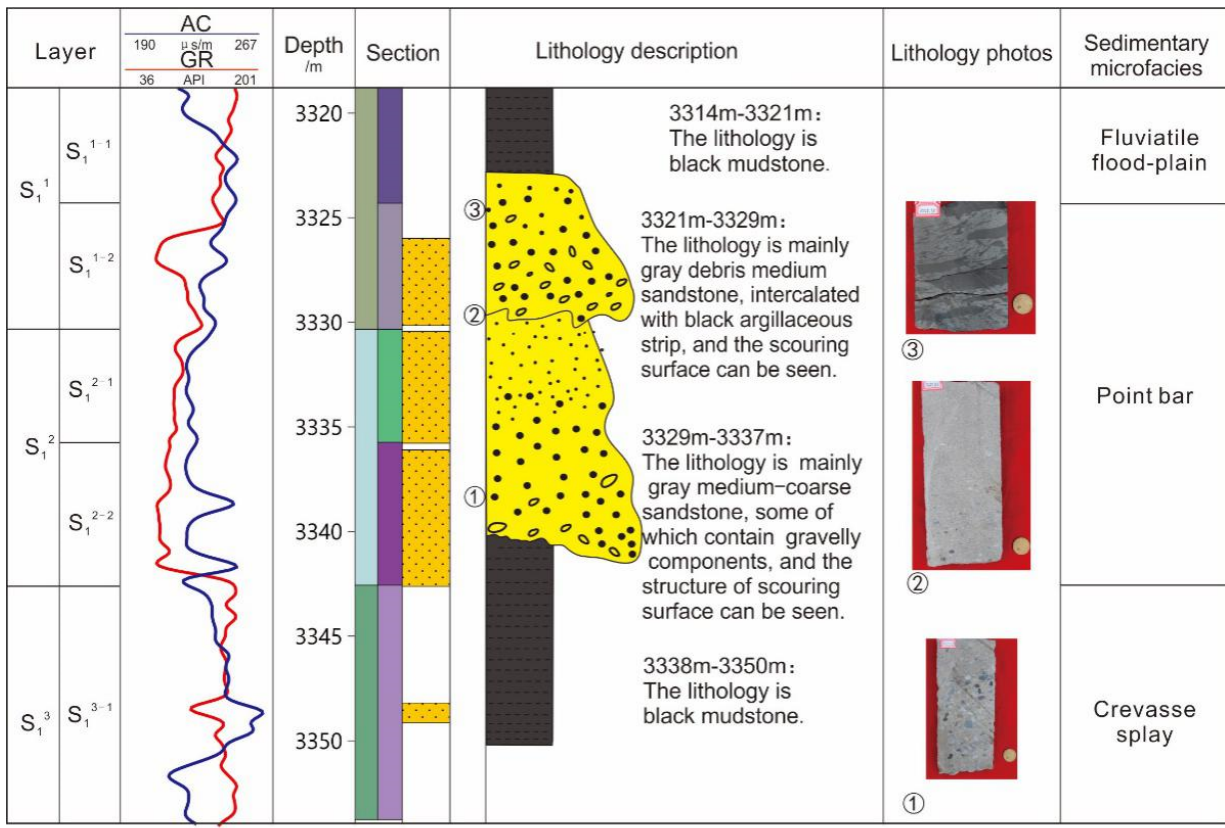
Figure 8. Lithologic characteristics in study area. ( a ) Well 94, erosion surface, 3320.94 m; ( b ) well 82, pebbly sandstone, 3330.58 m; ( c ) well 64, parallel bedding, 3338.16 m; ( d ) well 8, sandstone, 3363.04 m; ( e ) well 74, mud, 3358.03 m.